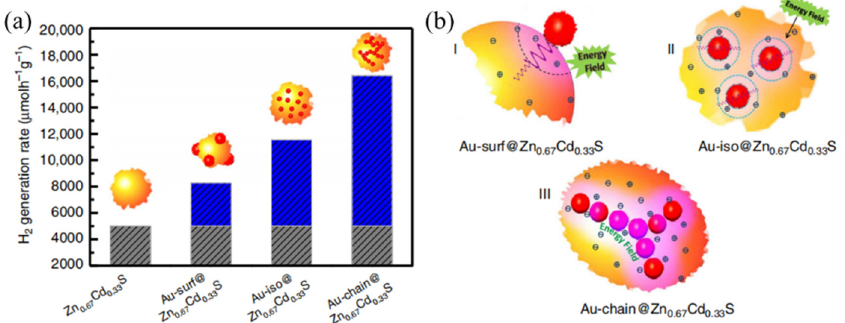
Figure 6. ( a ) Photocatalytic H 2 evolution activity of pure Zn 0.67 Cd 0.33 S and Zn 0.67 Cd 0.33 S supported by Au nanoparticles with different spatial arrangements (Au@Zn 0.67 Cd 0.33 S) under visible light irradiation ( ≥ 420 nm); blue columns represent the enhancement promoted by plasmonic-Au nanostructures. ( b ) Illustration for the proximity of semiconductors to the electromagnetic fields of plasmonic Au nanoparticles [46].